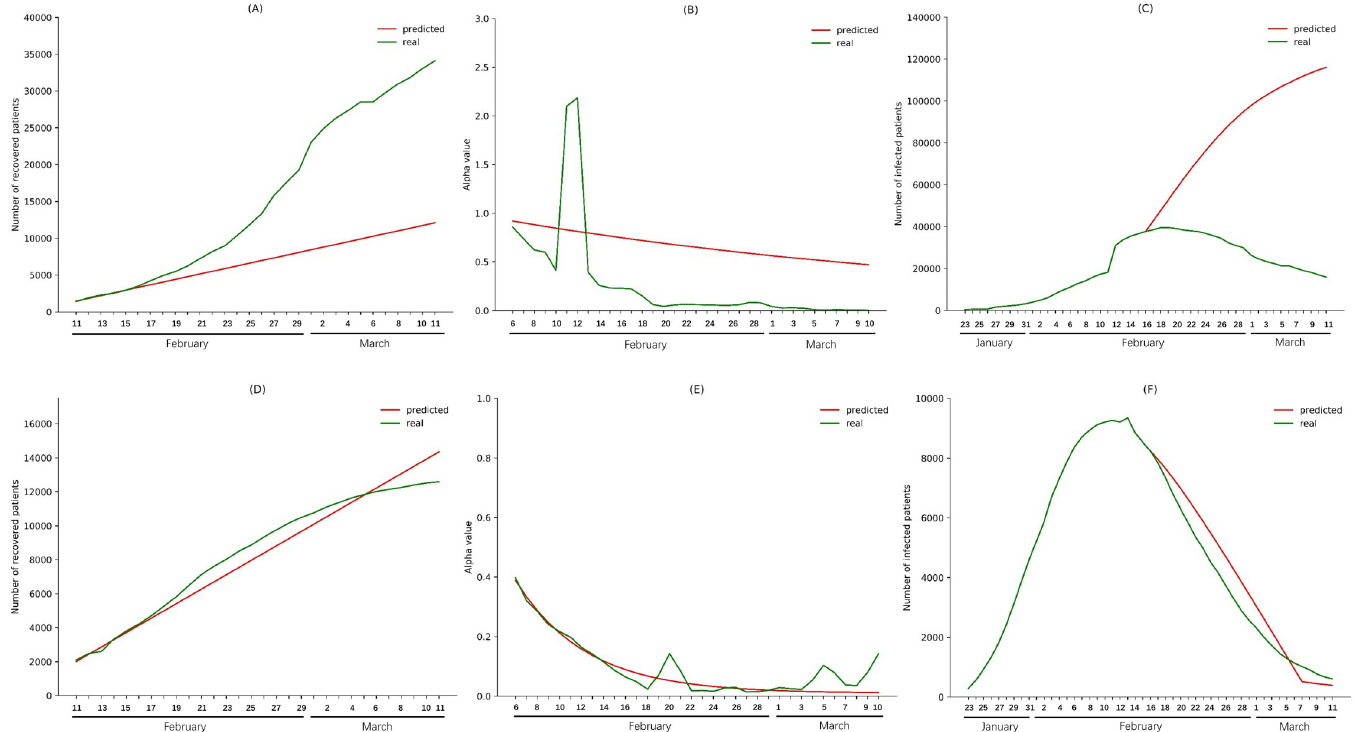
Fig 4. Impact of intensive community screening on Wuhan city and China excluding Hubei province. (A) The φ values from February 11 to February 15 (before intensive community screening) were fitted to predict the φ values for Wuhan city from February 16 to March 11 without intensive community screening. (B) The α values from February 6 to February 15 (before intensive community screening) were fitted to predict the α values for Wuhan city from February 16 to March 10 without intensive community screening. (C) The predicted α values and φ values were used to calculate the numbers of infections in Wuhan city from February 16 to March 11. (D) The φ values from February 11 to February 15 (before intensive community screening) were fitted to predict the φ values for China excluding Hubei Province from February 16 to March 11 without intensive community screening. (E) The α values for China excluding Hubei Province from February 6 to February 15 were used to predict the α values for China excluding Hubei Province from February 16 to March 10 without intensive community screening. (F) The predicted α values and φ values were used to calculate the numbers of infections in China excluding Hubei Province from February 16 to March 11.